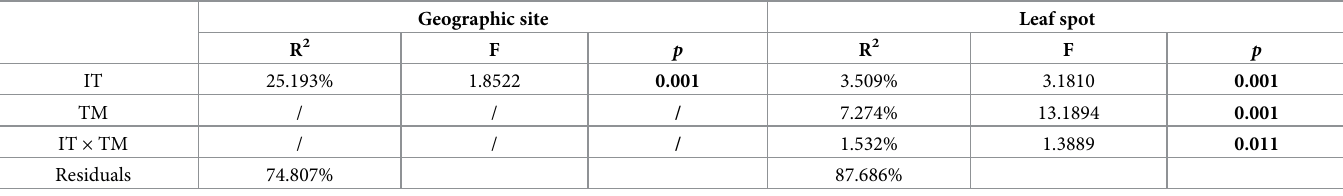
Table 1. PERMANOVA tests for the differences in microbial community